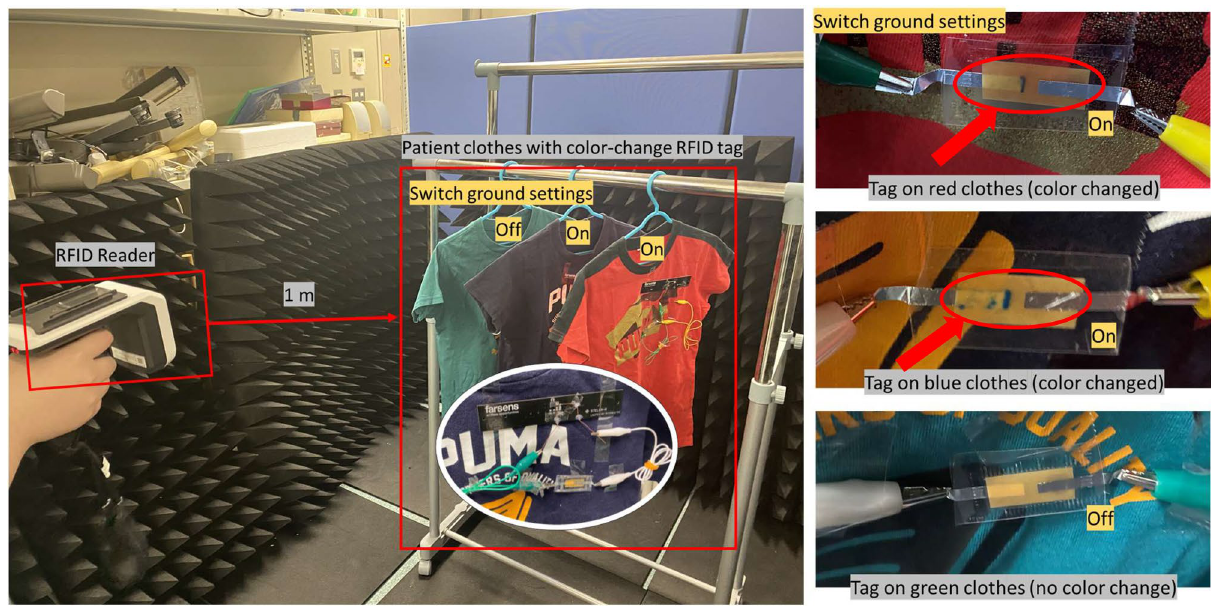
change positions are specified by red arrows and circles.